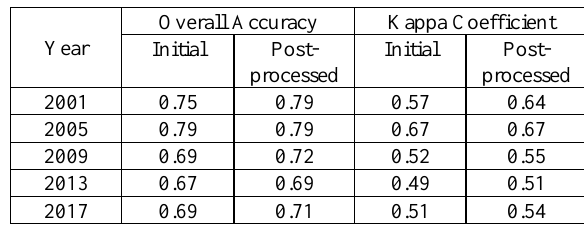
Figure 3. NDVI profiles of different land cover classes Two types of agricultural land cover classes were identified based on their NDVI profiles. Agricultural 1 correspond to perennial cropland areas, which are for plants with longer agricultural cycles such as fruit trees. The profile shows a steadily high NDVI values which may drop after several months or even more than a year. Agricultural 2 shows the profile of croplands with agricultural cycles of five to six months as shown by two peaks within a year. One cycle shows clearly the phenology of the crops in which the increasing NDVI marks the growth period, the peak indicates the time when the crops are fully grown, and the decreasing NDVI happens during the harvest season. The minimum in the plot marks the post-harvest